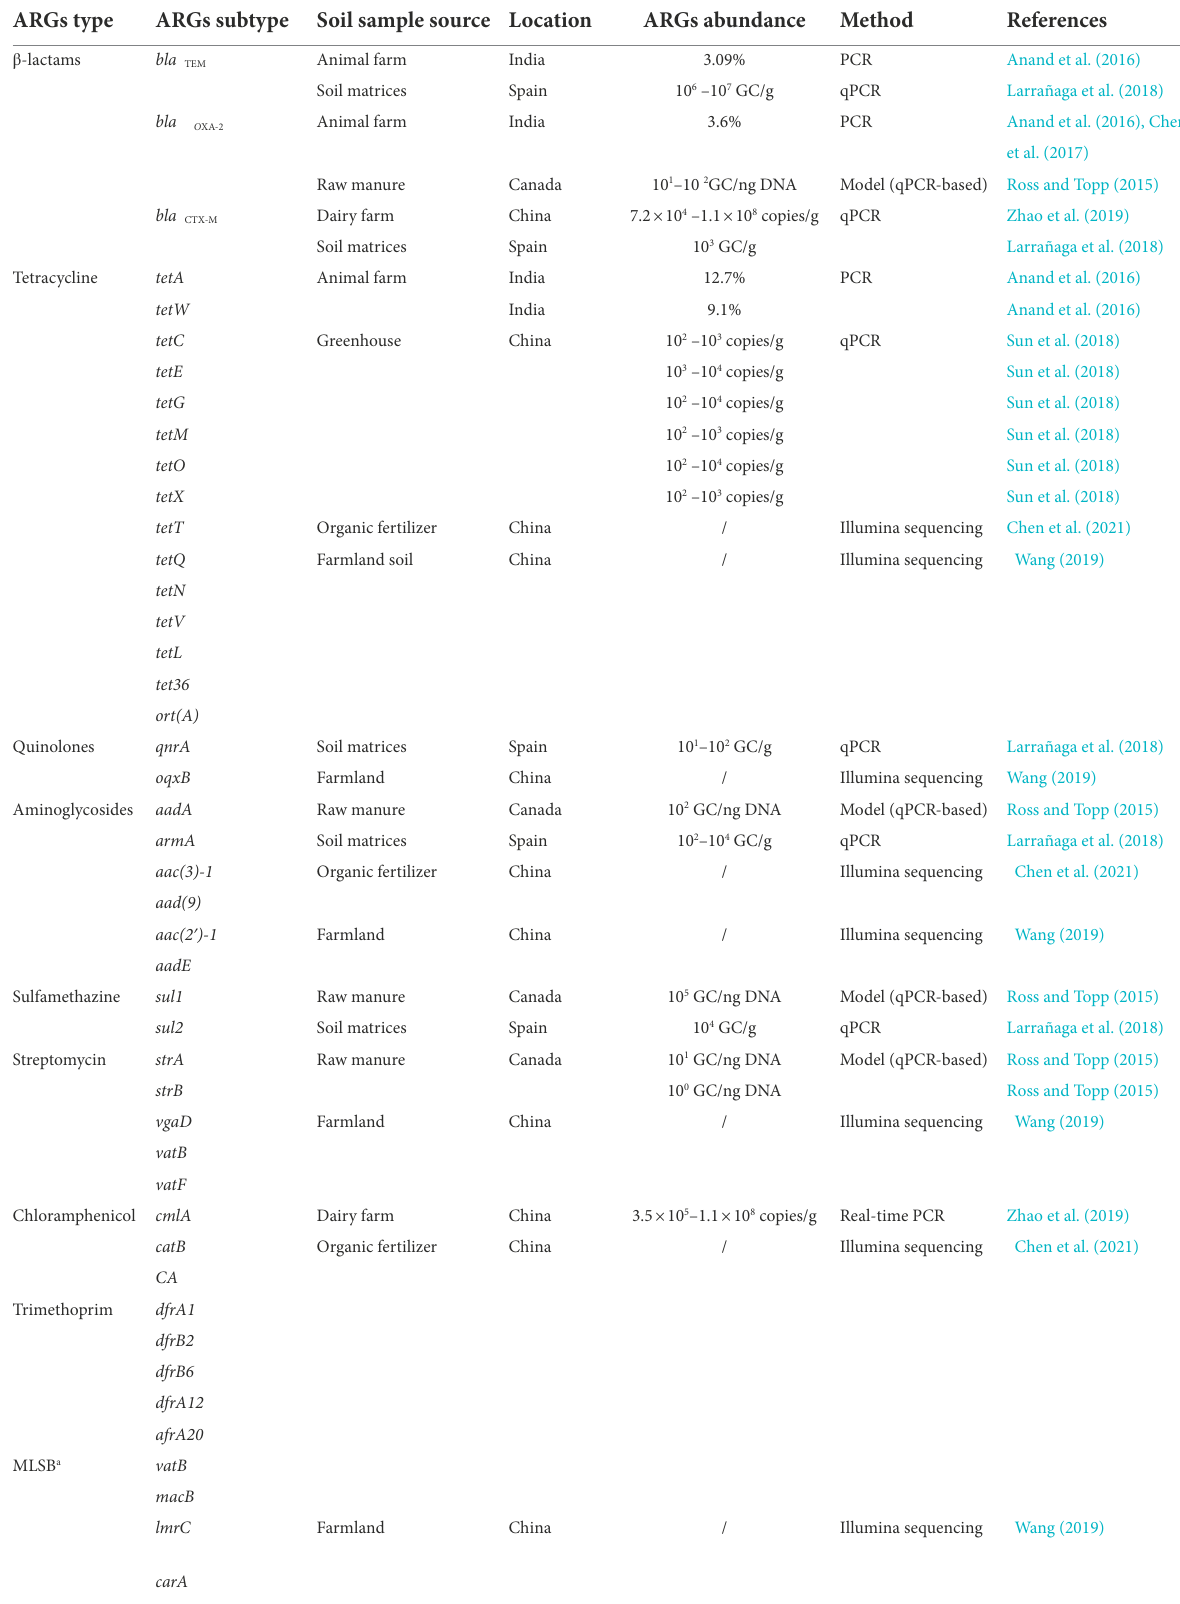
TABLE 2 Subtypes and abundance of antibiotic resistant genes (ARGs) in soilborne phage